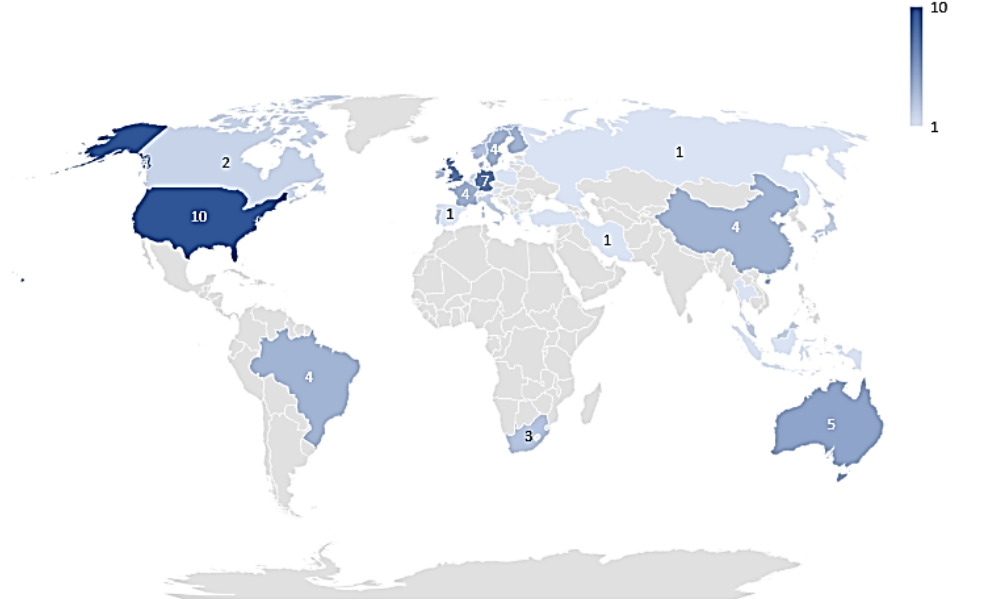
Figure 5. Frequency of the publication per country—by the lead author’s a ffi liation (source: own